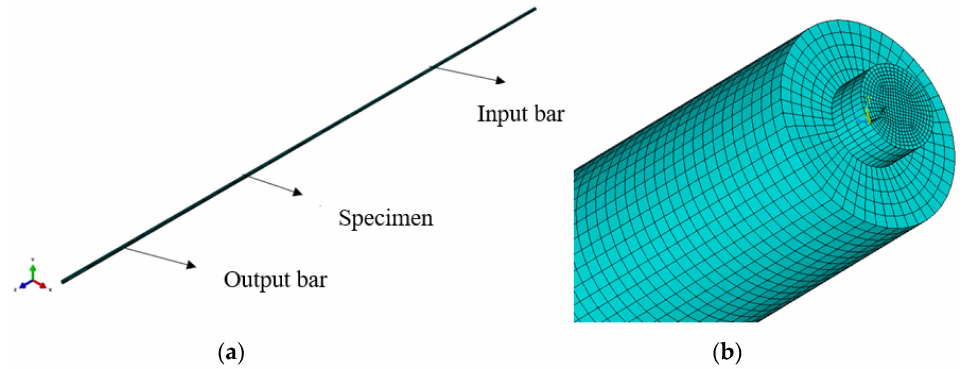
Figure 16. FE model of SHPB